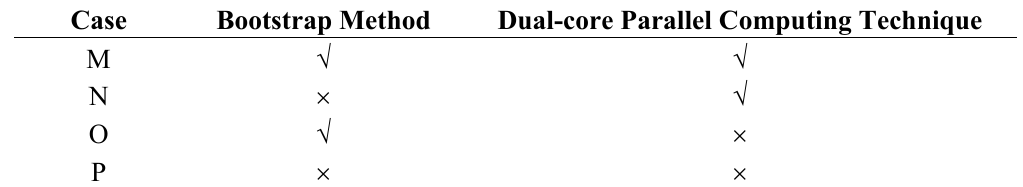
Table 11. The adopted methods of Case M, Case N, Case O and Case P.